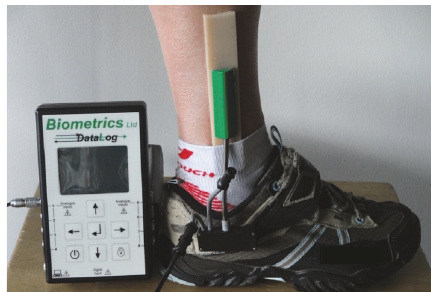
Figure 1: Data logger and position of the electrogoniometer end blocks on the lateral surface of the lower leg and